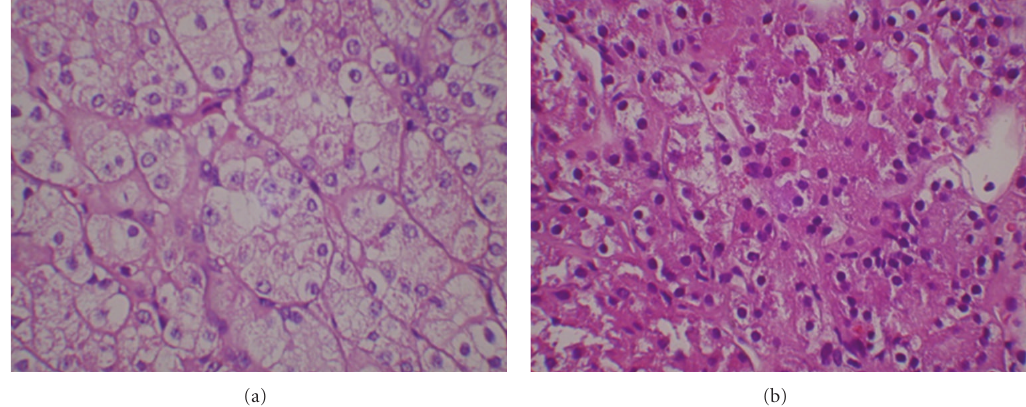
Figure 5: Microscopic views of H&E sections, demonstrating histological features of both oncocytoma and conventional variant of renal cell carcinoma.